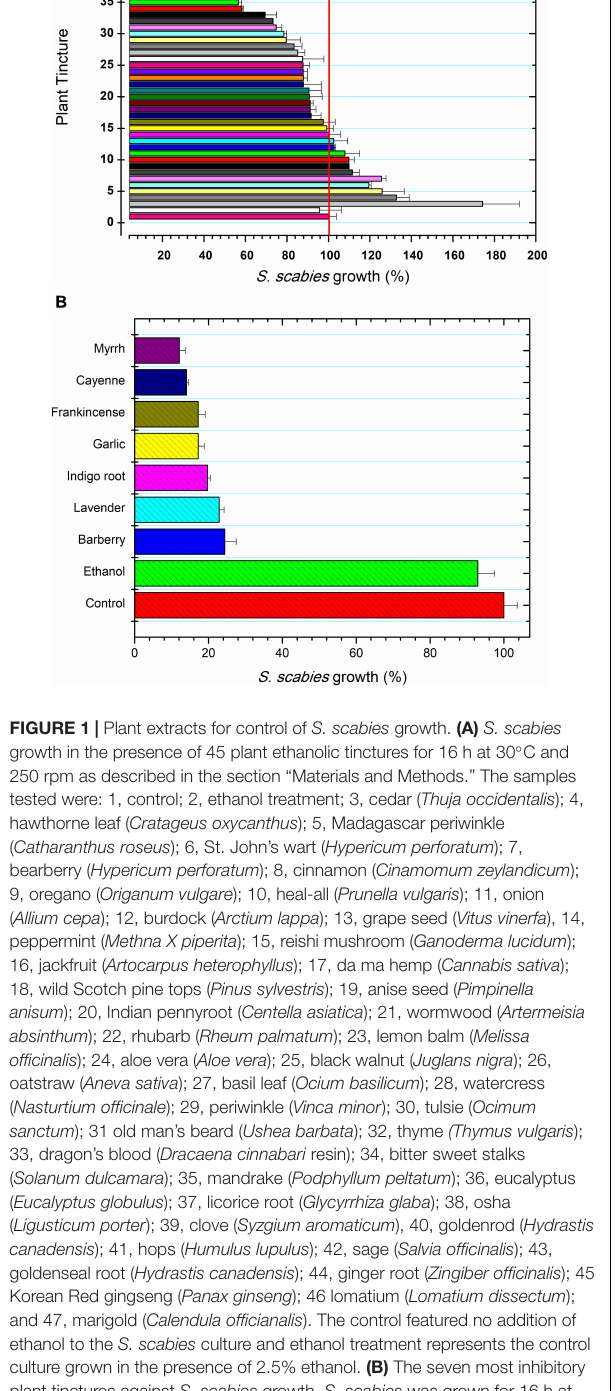
ethanol to the S. scabies culture and ethanol treatment represents the control culture grown in the presence of 2.5% ethanol. (B) The seven most inhibitory plant tinctures against S . scabies growth. S . scabies was grown for 16 h at 30 ◦ C and 250 rpm as described in the section “Materials and Methods.” Each bar represents the mean of triplicate experiments ± standard